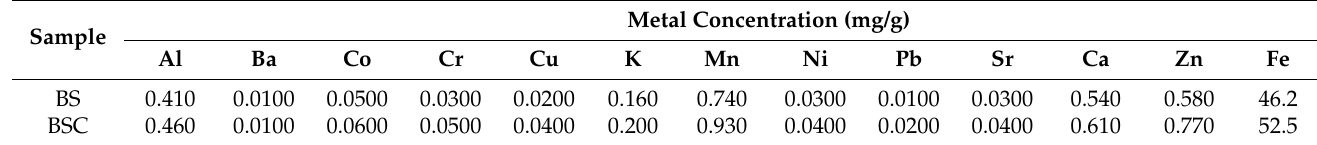
Figure 5. XRD results of Biosolid (BS) and Biosolid biochar (BSC). Table 4. Metal analysis of BS and BSC samples using the acid-digested method. Table 3. EDS microanalysis of Biosolid (BS) and Biosolid biochar (BSC) samples